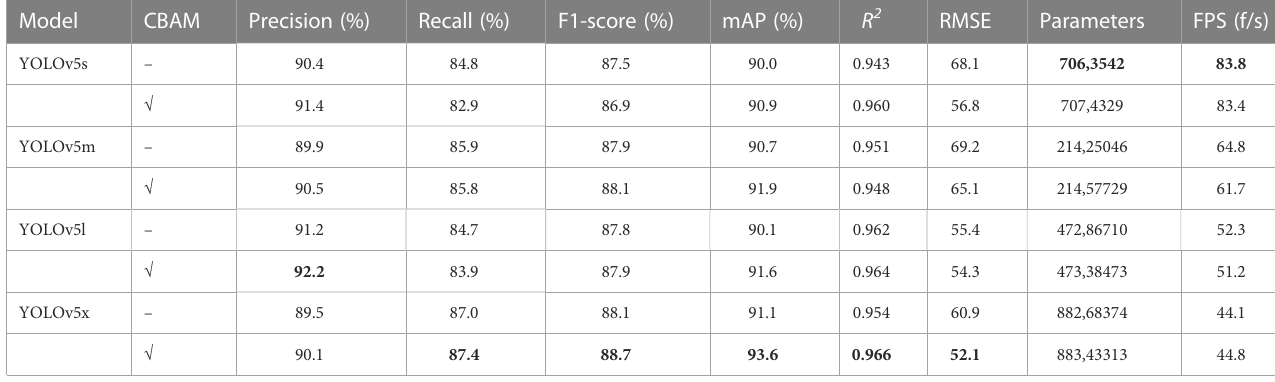
TABLE 2 Experimental results of four YOLOv5 network structures before and after improvement. Model